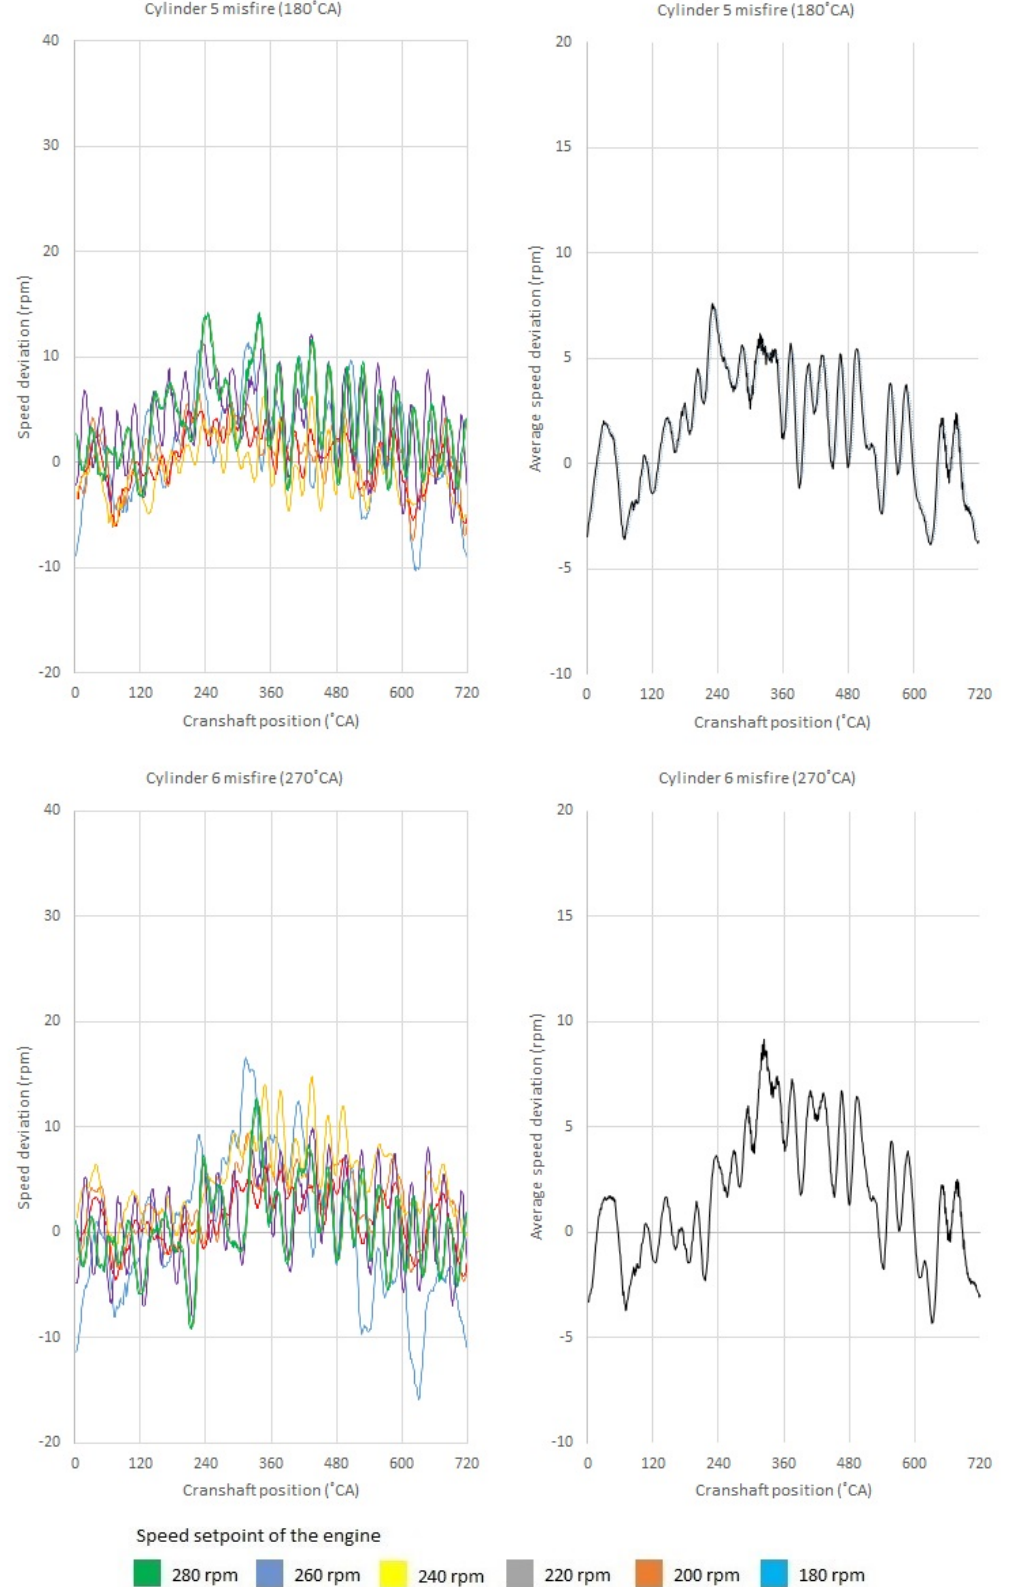
Figure 17. Instantaneous speed differences and the average deviation of the combustion loss in cylinders 5 and 6 of the Buckau-Wolf R8DV-136 engine.